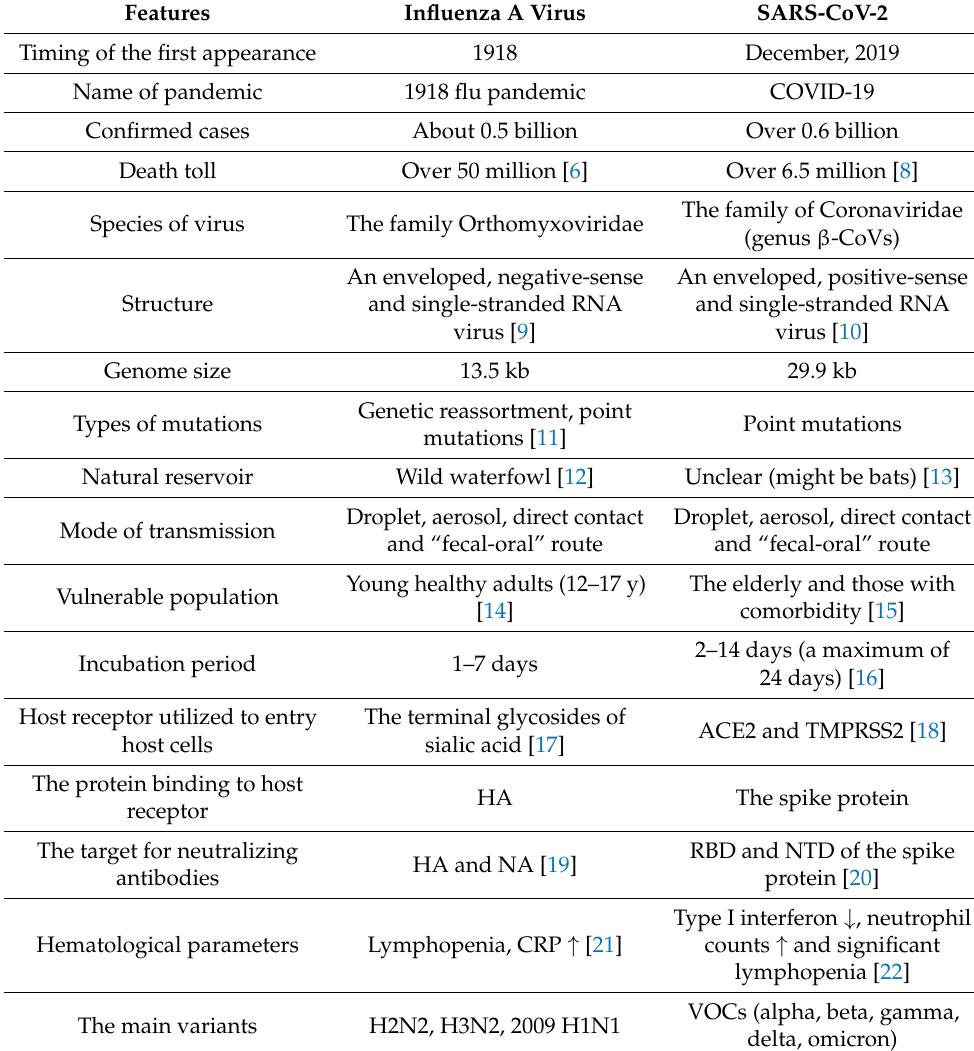
Table 1. The comparison of the characteristics of influenza A virus and